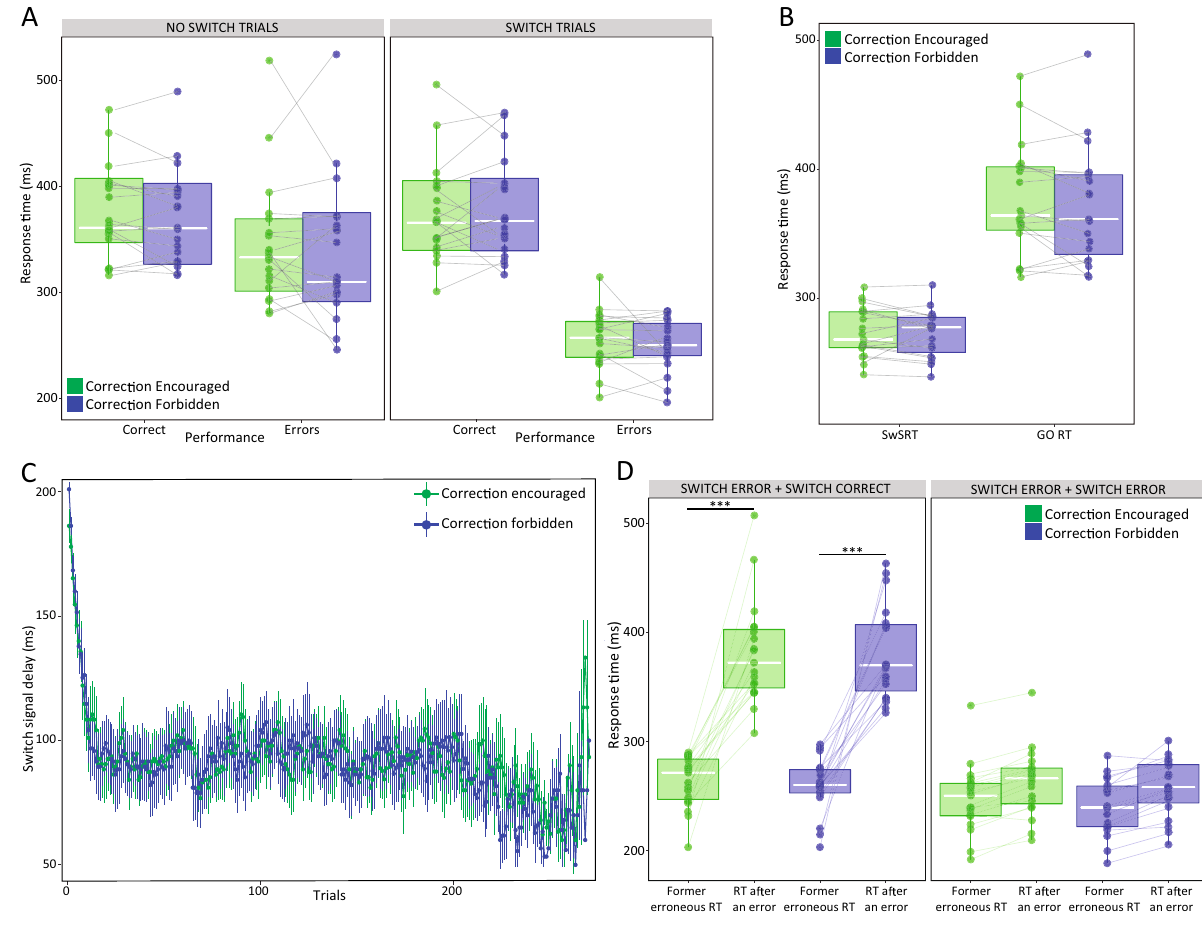
Figure 2. ( A ) Average RT for correct and erroneous responses separately for no-switch and switch trials in the two degrees of inhibitory control. ( B ) Average SwSRT and Go RT in the Encouraged and Forbidden correction condition. ( C ) Changes in the SwSD for each correction instruction are illustrated with respect to trial number. Solid thick lines connect 240 points corresponding to the inter-subject mean for each trial, while the error bars represent the standard error of the mean (SEM). ( D ) Average RT for correct and erroneous responses following an error in switch trials, separately for the two correction instructions. In all boxplots, the bold white line shows the median, and the bottom and top of the box show the 25th (quartile 1 [Q1]) and the 75th (quartile 3 [Q3]) percentile, respectively. The upper whisker ends at highest observed data value within the span from Q3 to Q3 + 1.5 times the interquartile range (Q3–Q1), and lower whisker ends at lowest observed data value within the span for Q1 to Q1-(1.5 * interquartile range). Points not reached by the whiskers are outliers. Significant post hoc group comparisons are represented by solid lines above. * p < .05; ** p < .01; *** p <